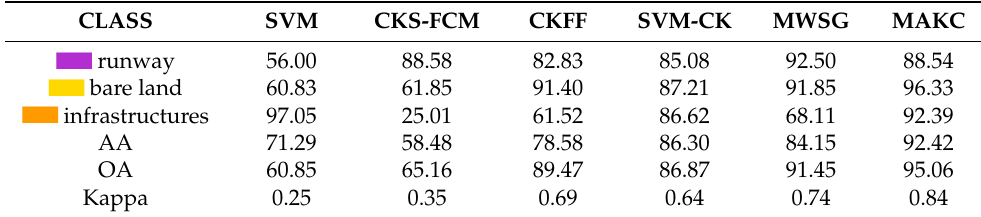
Table 3. Classification precision results on SAR1.